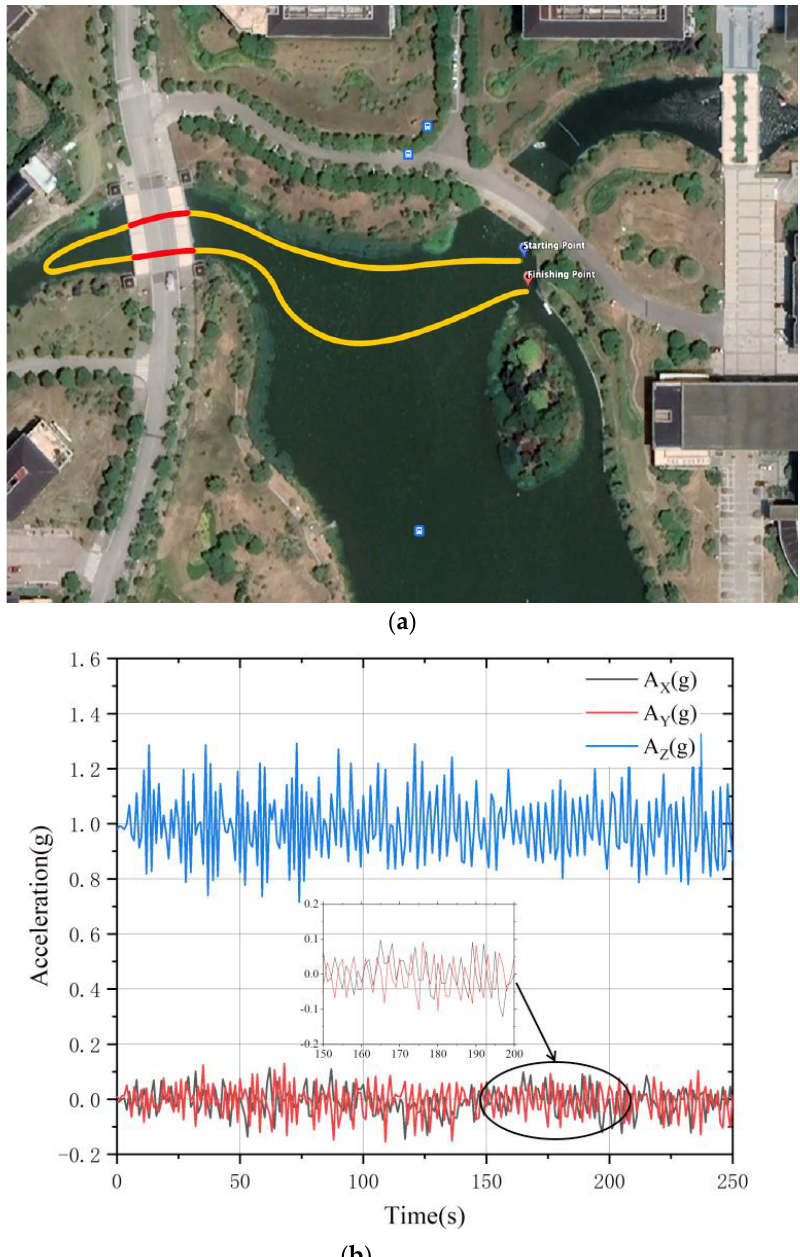
Figure 9. Experiment II navigation test: ( a ) navigation route, red represents track in GNSS-challenged environment, yellow represents outdoor track; ( b ) System acceleration after fusion.